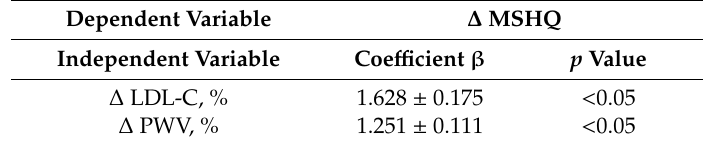
Table 3. Simple linear regression analyses evaluating ∆ MSHQ as dependent